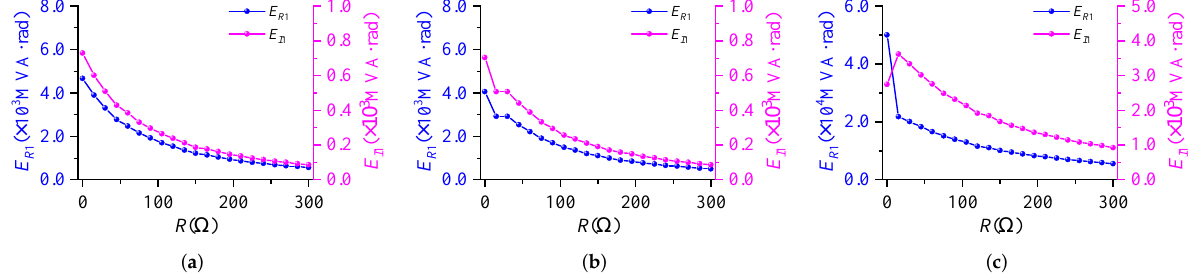
Figure 13. Fault direction identification coefficients with different fault resistances. ( a ) PG